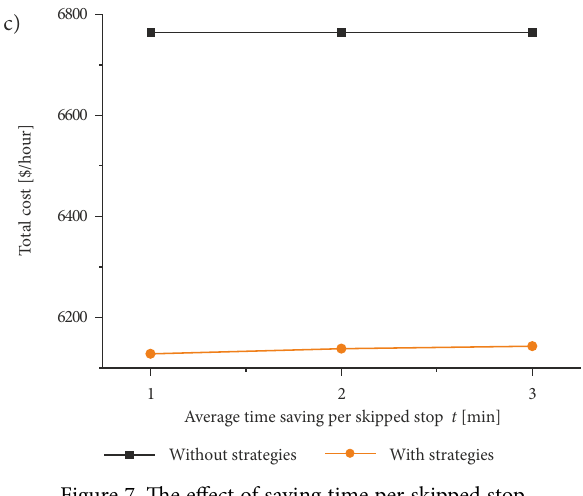
Figure 7. The effect of saving time per skipped stop parameter t on optimal results: a – total costs; b – passenger costs; c – operator